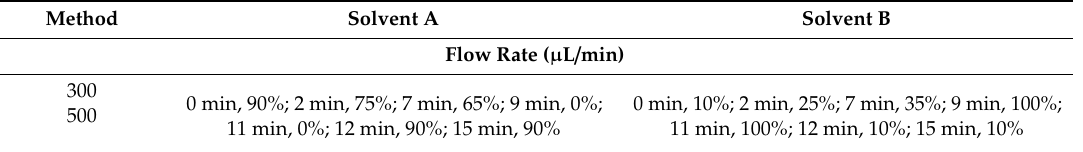
Table 3. Mobile phase gradient elution of di ff erent flow rates and gradient elution